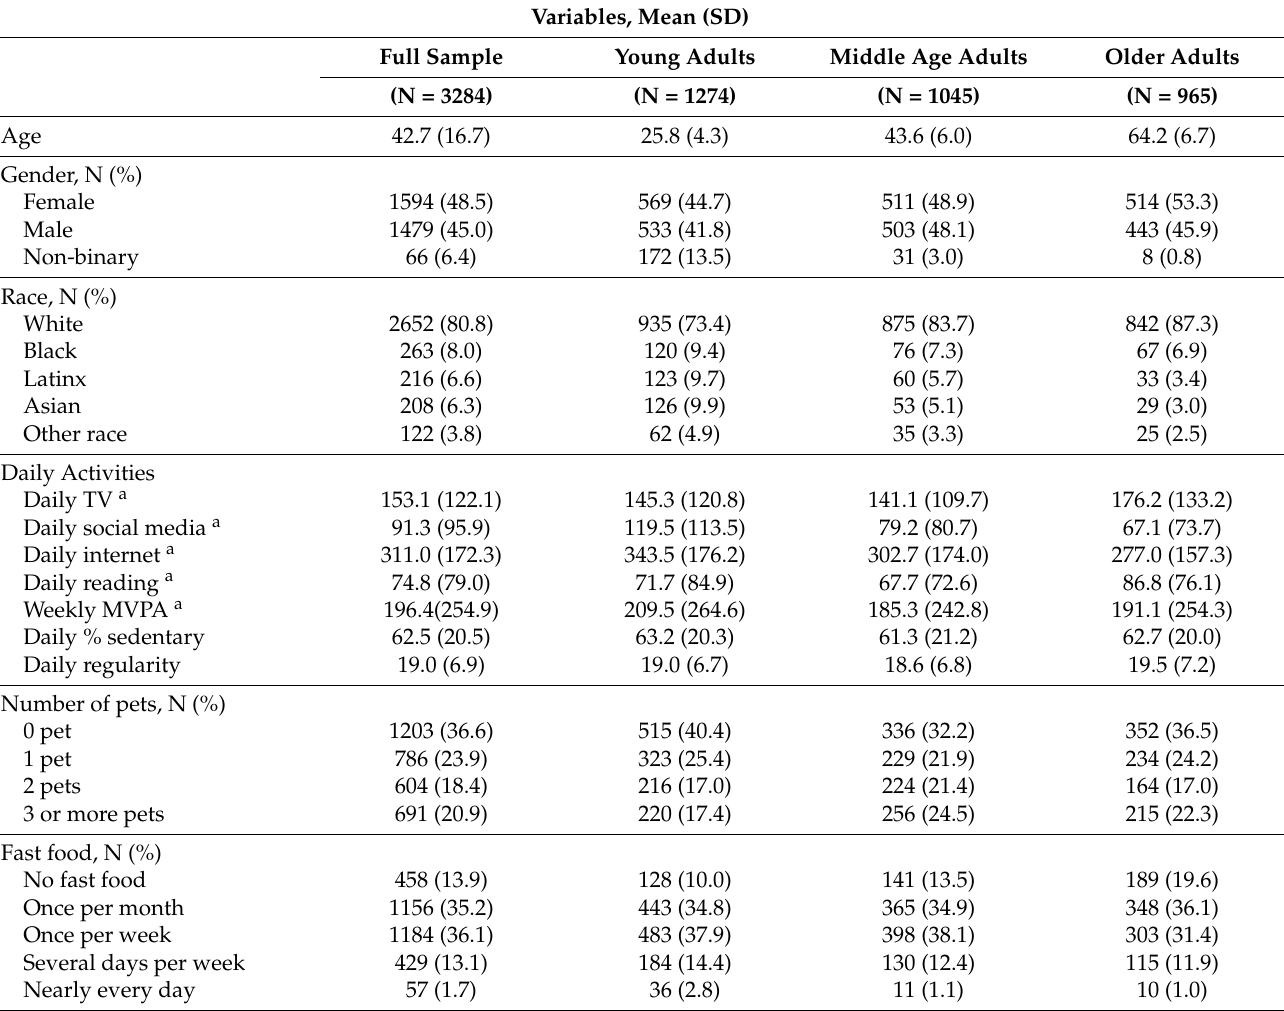
Table 1. Participant Descriptive